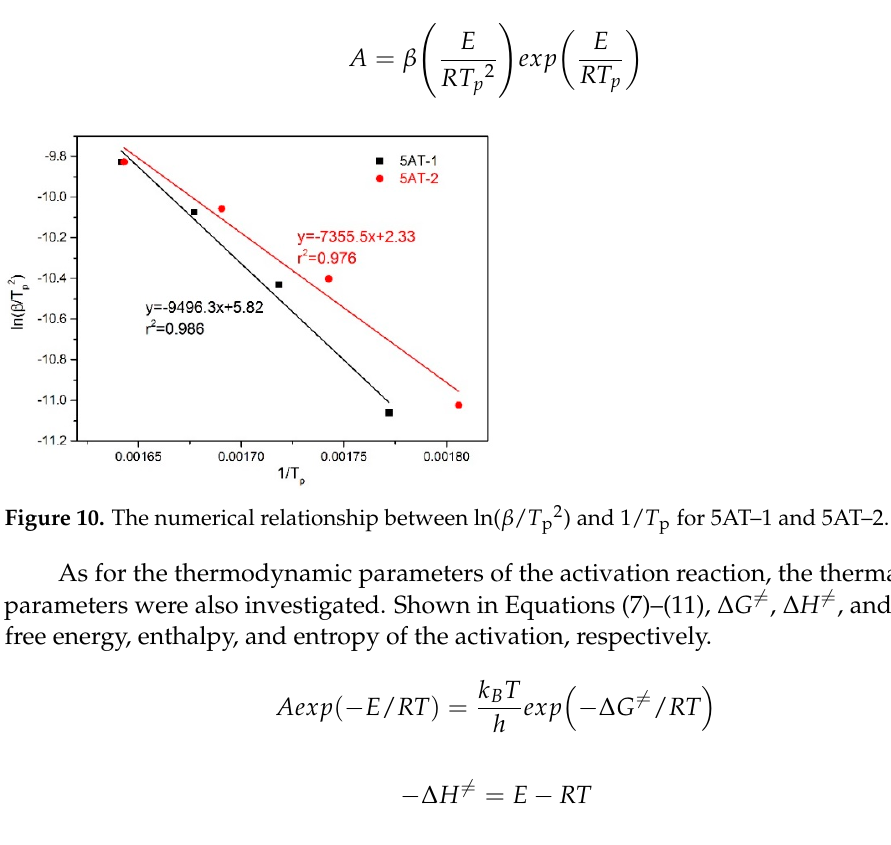
Figure 9. The e ff ect of varying the heating rate of 5AT–1 and 5AT–2 on T o , T onset , and T p .